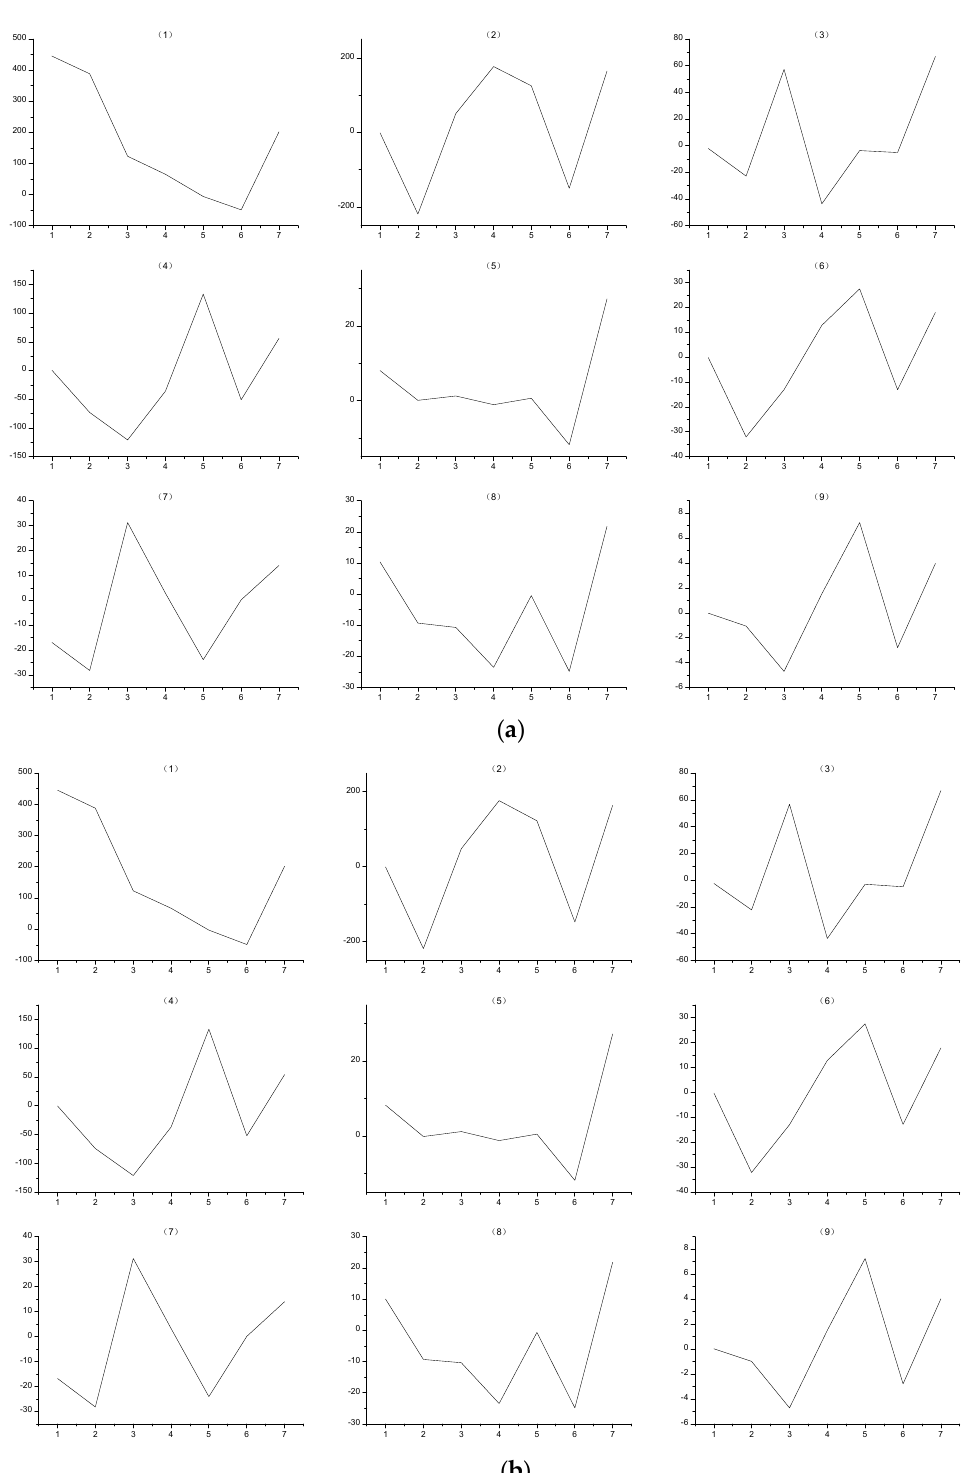
Figure 14. The part wavelet packet coefficient group before and after predicted. ( a ) Original part wavelet packet coefficient group; ( b ) Part wavelet packet coefficient group of peak-type Markov chain prediction.